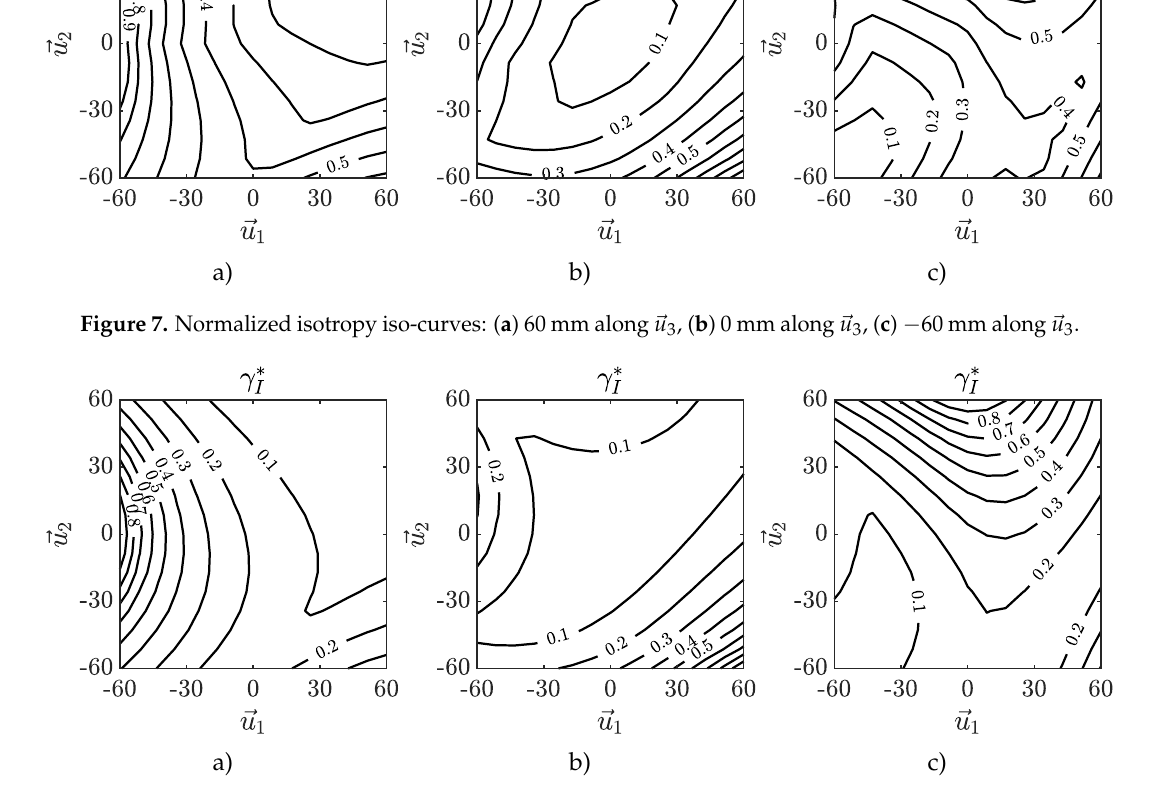
Figure 8. Normalized volumetric isotropy iso-curves: ( a ) 60 mm along (cid:126) u 3 , ( b ) 0 mm along (cid:126) u 3 , ( c ) − 60 mm along (cid:126) u 3